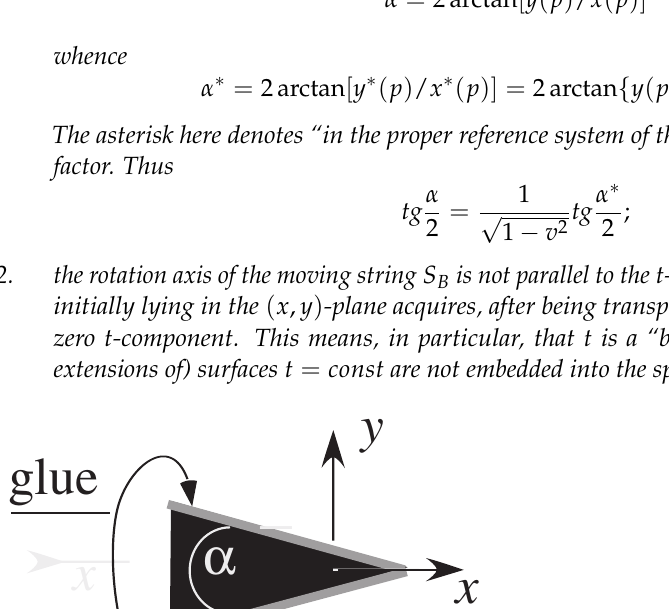
for a certain t 0 (to convert the former to A t 0